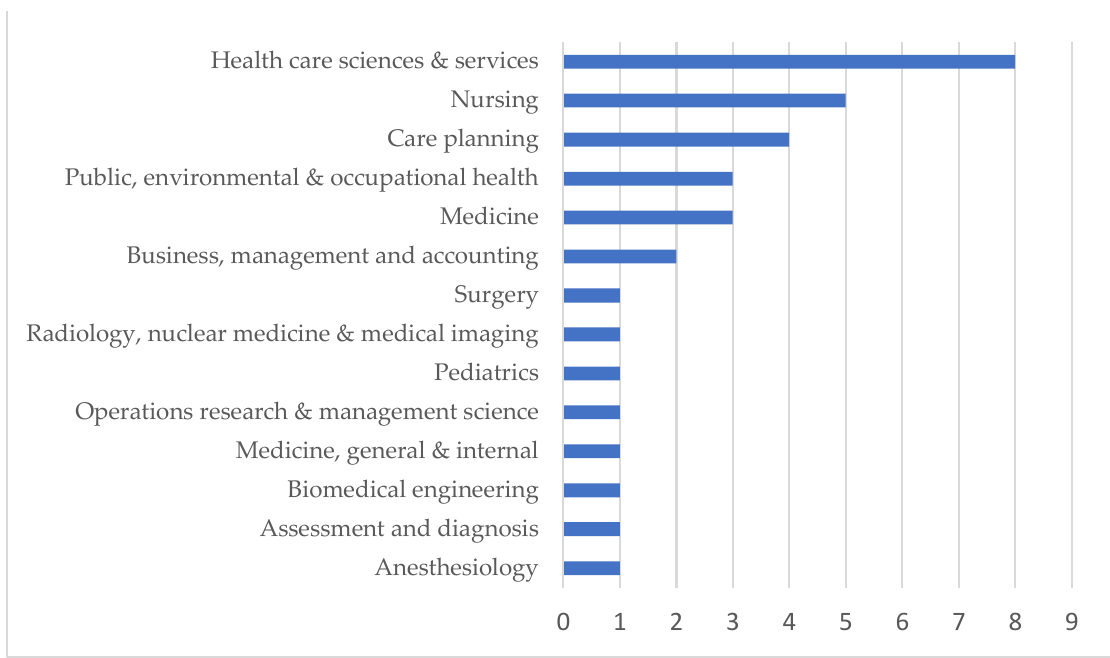
Figure 3. Academic fields. Figure 3. Academic